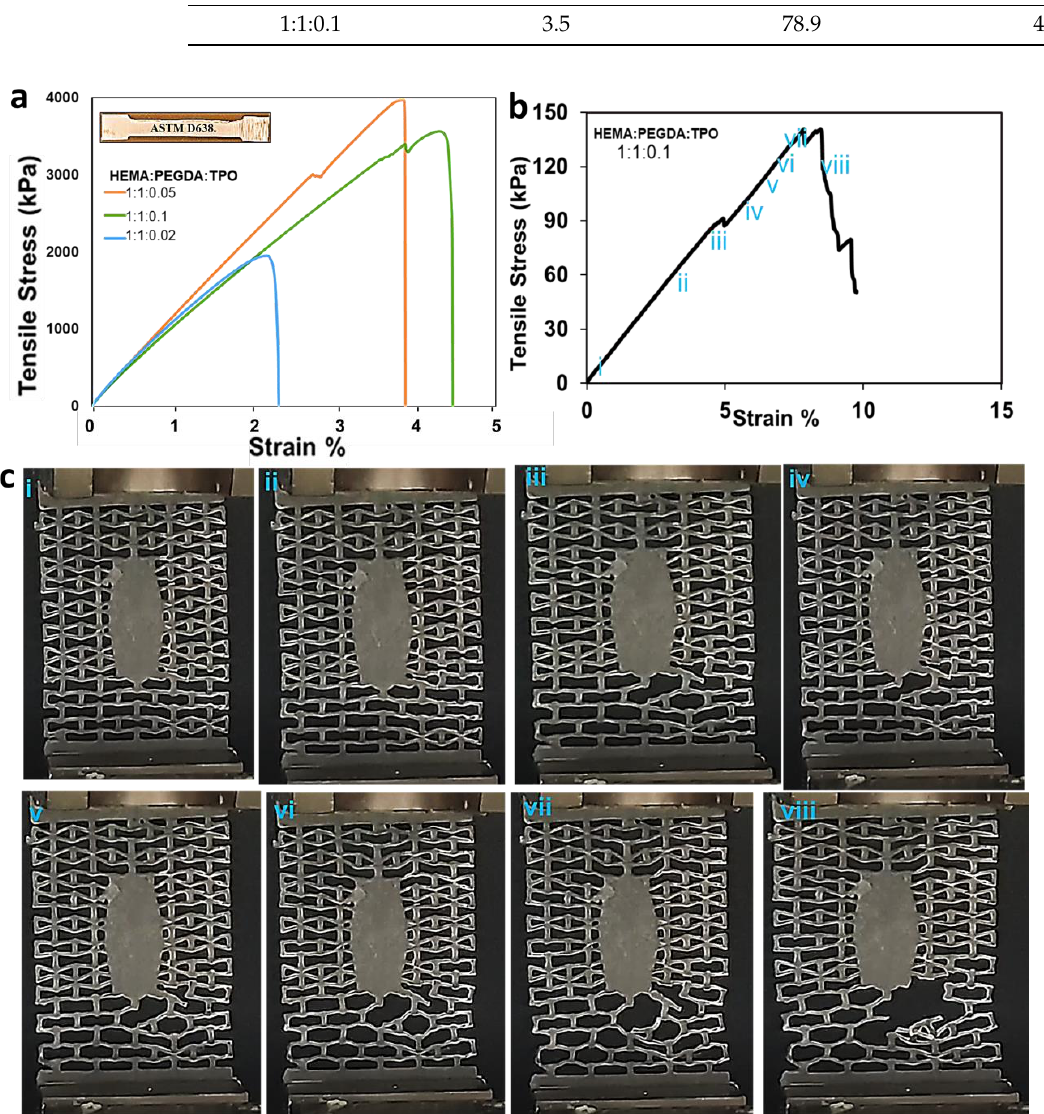
Figure 6. ( a ) Tensile stress–strain curves for 3D printed hydrogels with different HEMA: PEGDA: TPO concentrations. ( b ) The mechanical strength corresponding to the re-entrant unit cell fail representation using stress and strain diagram.(i-vii) the elastic deformation section (viii) failure ( c ) Failing stage of the re-entrant unit cells. (i-viii) The response of the unit cells to the applied load. Scale 0.5 cm.